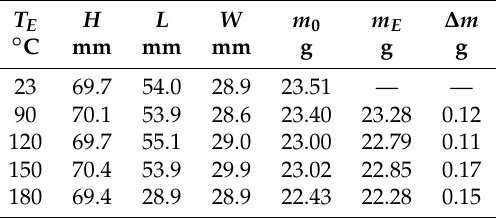
Table 1. Average physical dimensions and masses of the carbon fiber-reinforced plastic (CFRP) composite